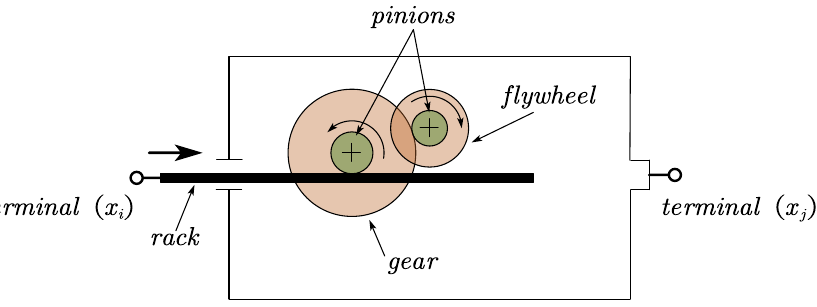
Figure 1. Schematic of a ball-screw mechanical model of an inerter [39].